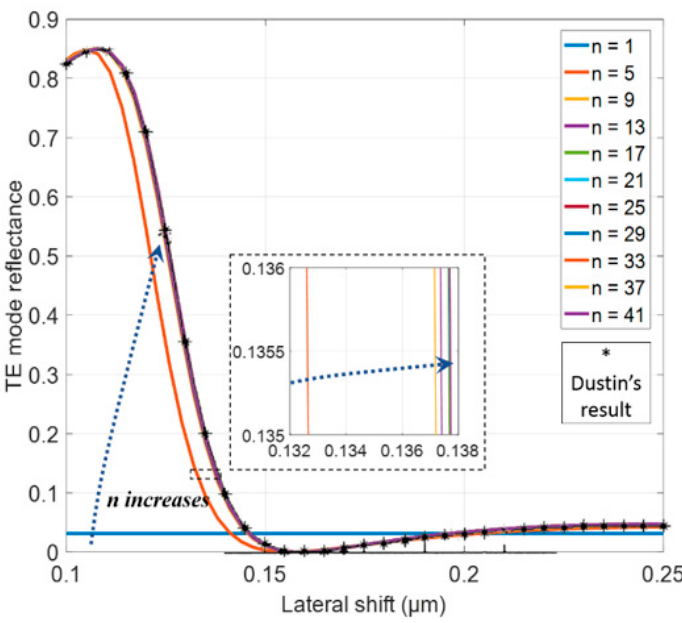
Figure 2. TE mode reflectance versus lateral shift of movable grating versus an increasing number of harmonics. The solid lines represent our simulation results and the asterisks represent Dustin’s results.